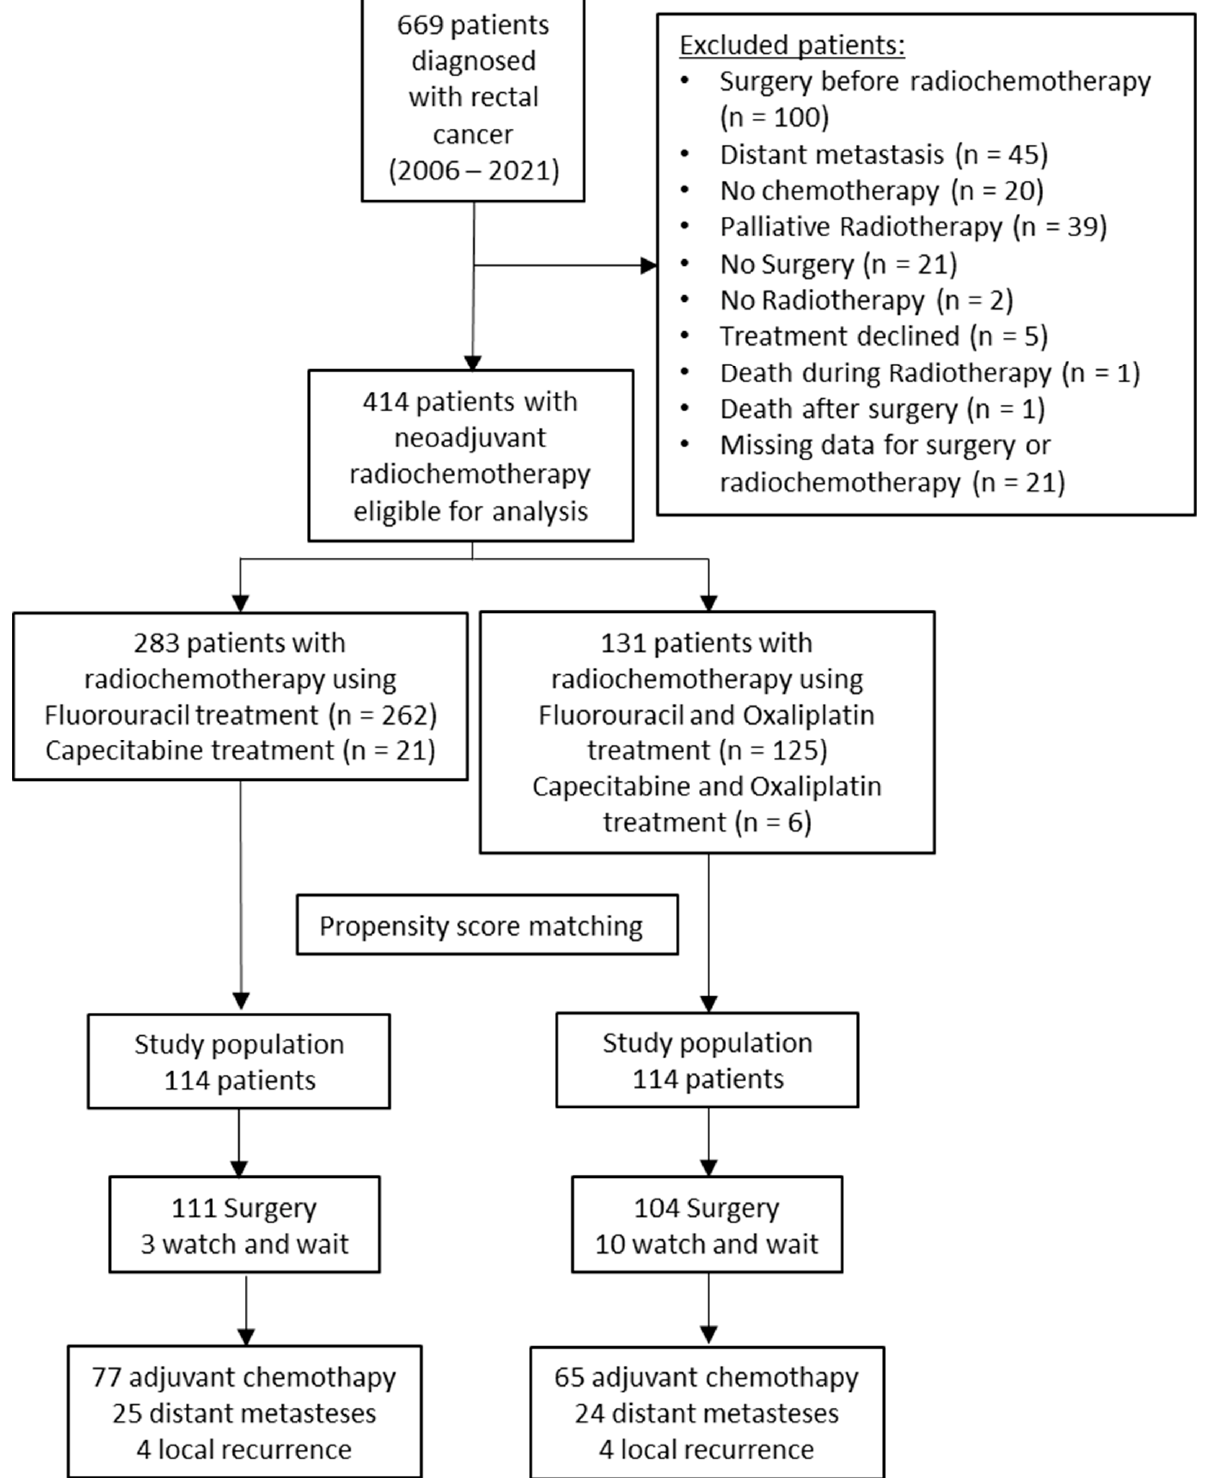
Figure 1. CONSORT flow diagram of the study population.